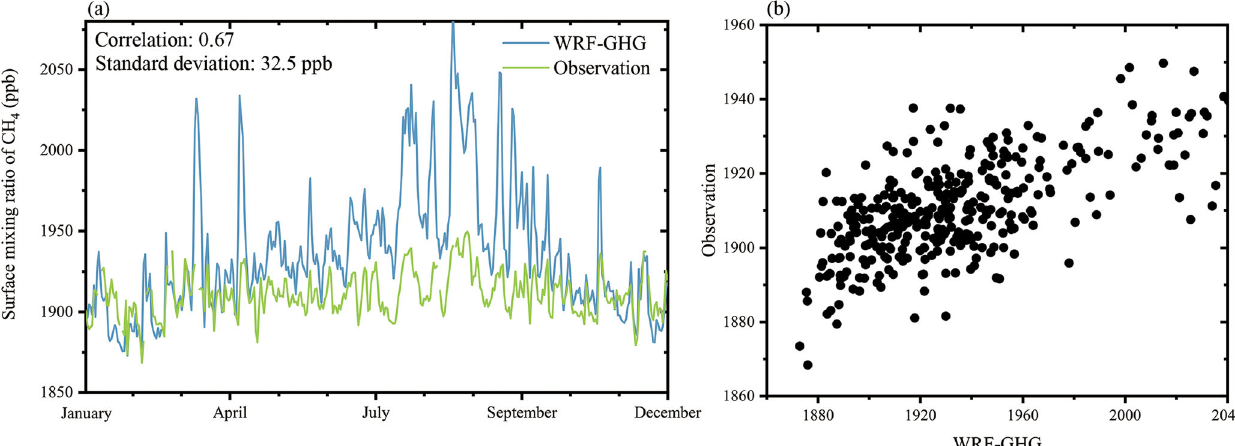
Fig. 2 Model evaluation of surface CH 4 . a Daily variations of surface CH 4 (unit: ppb) from observation (green) and WRF-GHG (blue) in 2017. b Scatter plot of simulated and observed surface CH 4 Table 1. 10-fold cross validation of reconstruction accuracy of four sensor placement algorithms ( n and P denote the number of POD modes and sensors, unit of MPE: %, unit of RMSE: ppb). n = 10 P = n P = 1.5 n P = 2 n